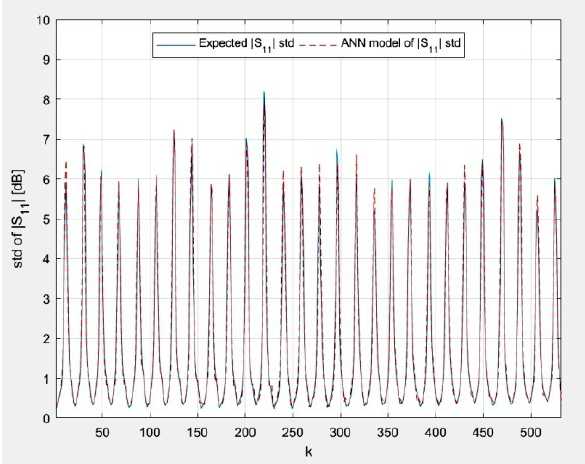
Figure 15. The expected and modeled standard deviation of | S 11 | of an ordinary patch antenna in the range of the training data; k is the consecutive input data no. that follows the rule indicated in (1).